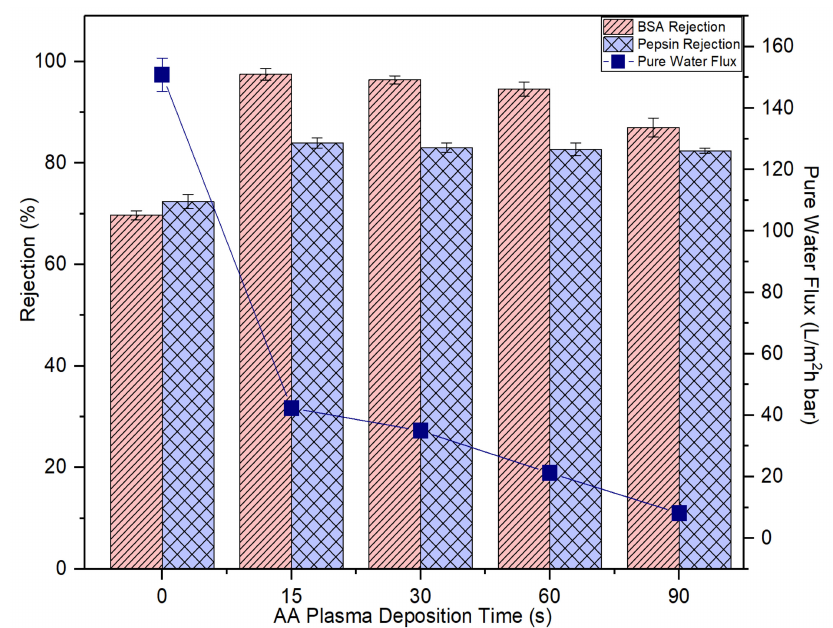
Figure 9. The impact of plasma deposition time of AA on the membrane pure water flux and solute rejection using 2000 mg / L bovine serum albumin (BSA) solution and 2000 mg / L pepsin solution. Error bars indicate standard deviations.